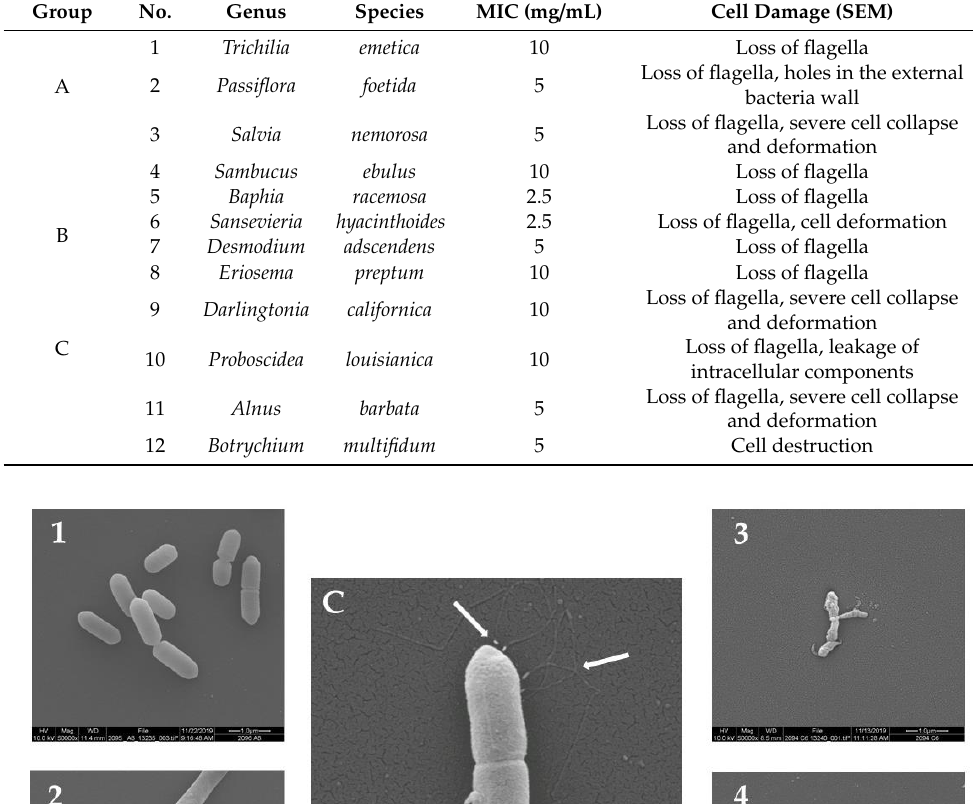
Table 2. Summary of the results obtained by SEM observations of the bacterial cells.